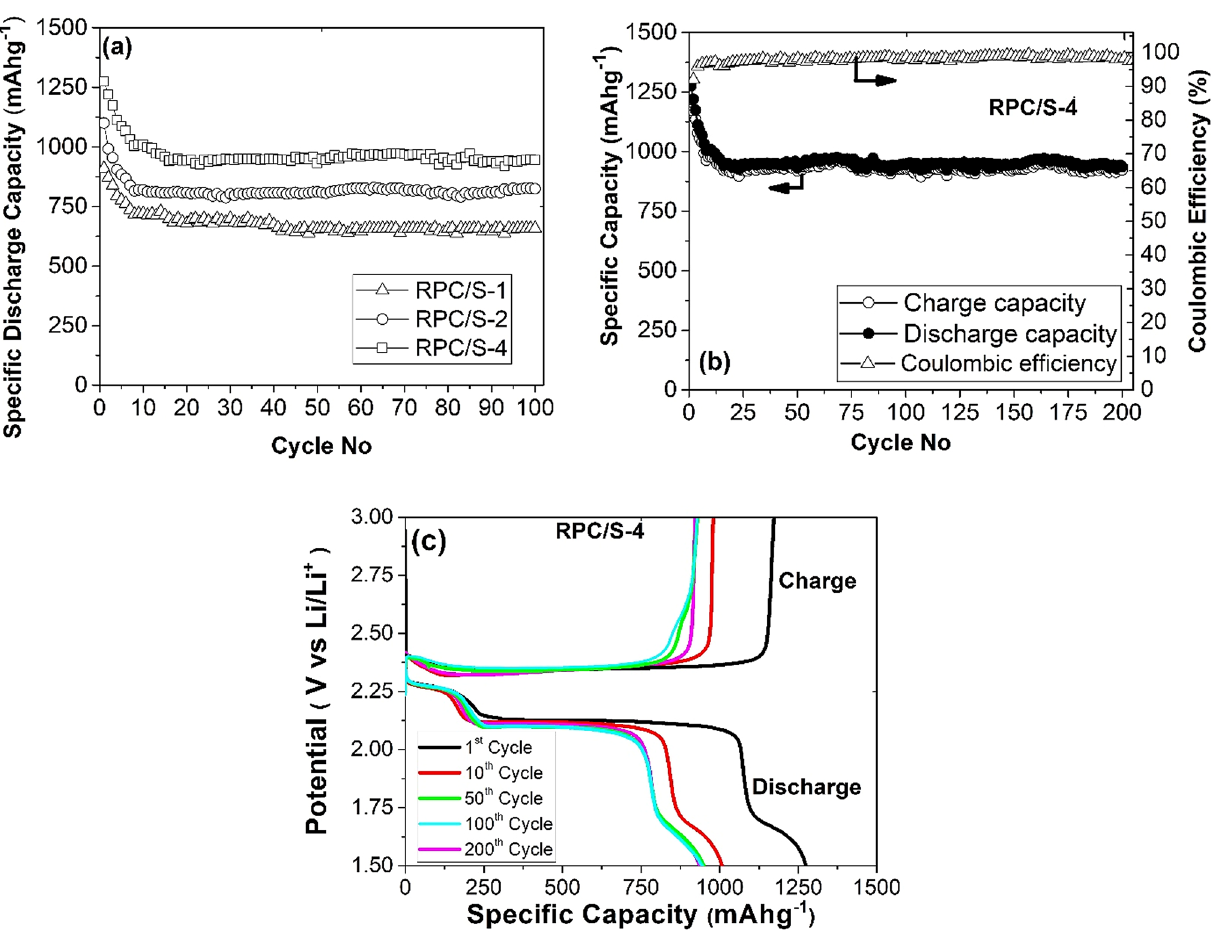
Fig. 6 a Comparison of cycle performance of all carbon–sulfur composites, b long cycle performance of RPC/S-4 and c galvanostatic charge–discharge profiles of RPC/S-4, measured at current density of 0.2 C and cut-off voltage between 1.5 and 3.0 V vs Li/Li